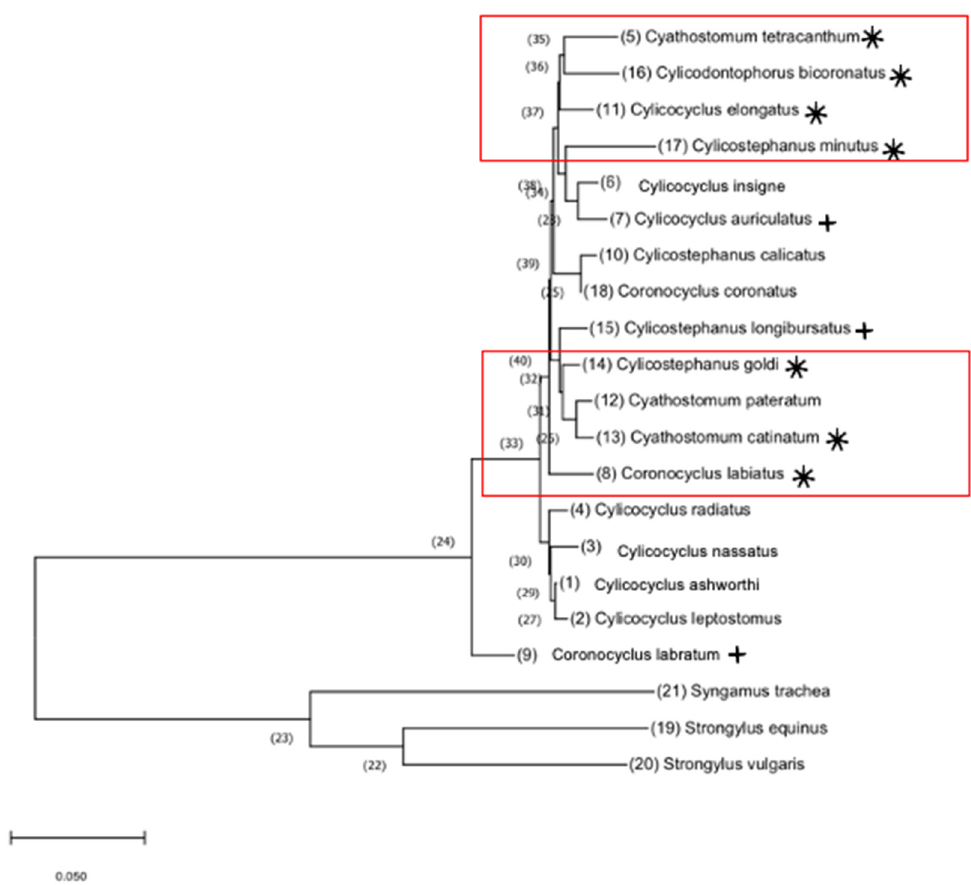
Figure 3. Phylogenetic relationships of equine cyathostomins based on full-length gene sequences. Maximum likelihood tree using bootstrap inference of equine cyathostomins in this study (accession numbers listed in Table 2). Syngamus trachea (KM605251) , Strongylus equinus (AP017698) , and Strongylus vulgaris (GQ888718) were included as outgroups. * indicates resistance to IVM, MOX, and PYR ( p ≥ 0.05). + indicates trending resistance (0.01 ≥ p < 0.05). to IVM, MOX, and PYR. Red boxes indicate the clustering of species presenting resistance.